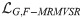
The evaluation results of MRMNet and TecoGAN-G on four different data sets, using the tLP metric.LG,F−MRMVSR is the loss function used.